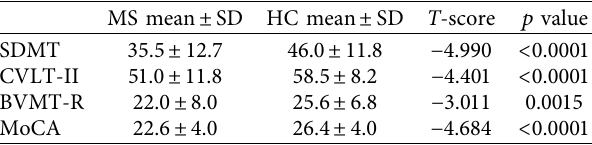
standard deviation; SPMS: secondary progressive multiple sclerosis. Table 2: Comparison of mean scores between patients and healthy